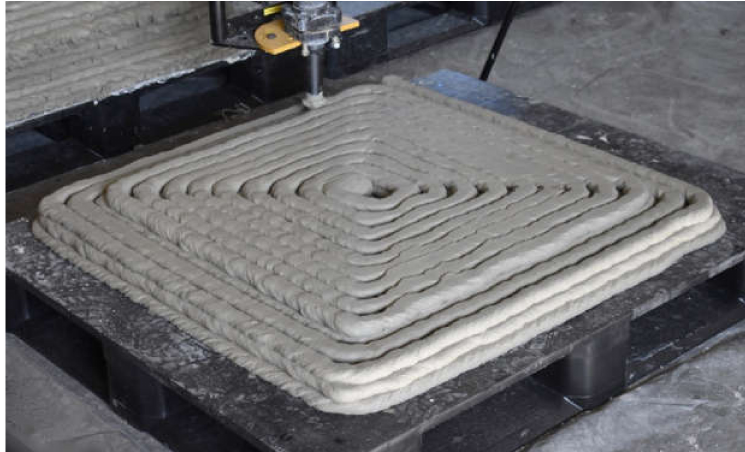
Figure 3. Printing Dragon’s Tooth